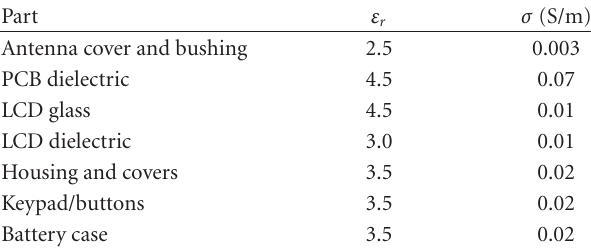
Table 1: The main dielectric parts of the handset CAD models and the corresponding material